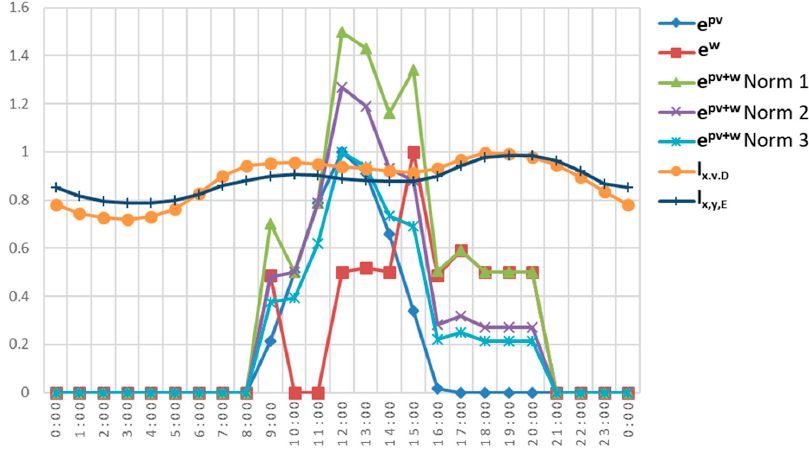
Figure 3. One-day-example of the normalised generation and load profile evolution.